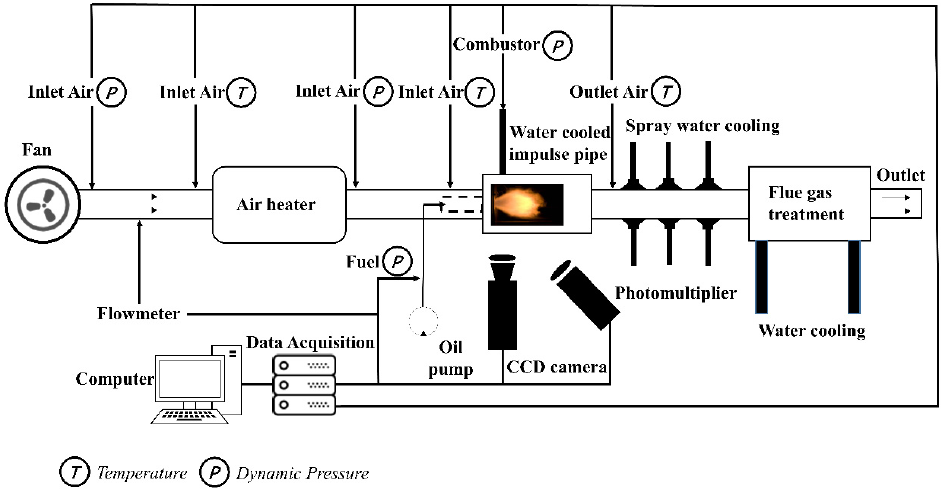
Figure 2. The structure and measurement layout of the L combustor.